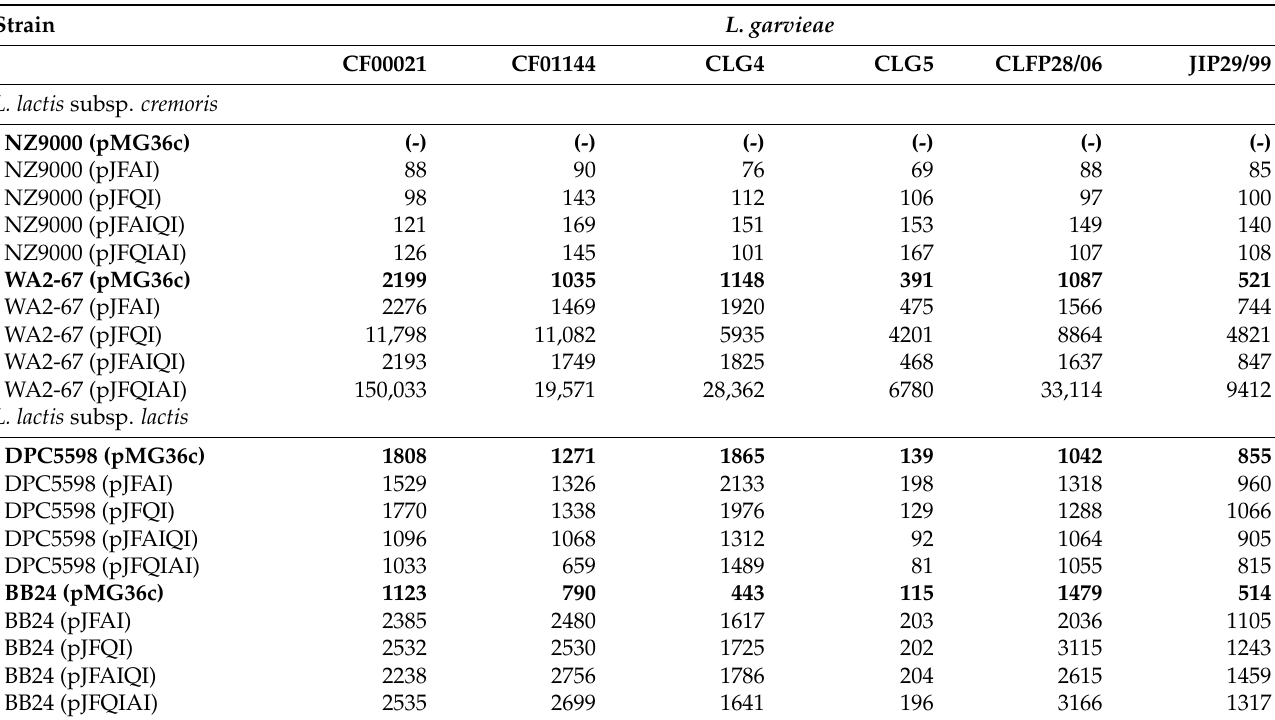
Table 3. Antimicrobial activity a of supernatants from recombinant L. lactis strains transformed with pMG36c-derived plasmids against virulent L. garvieae